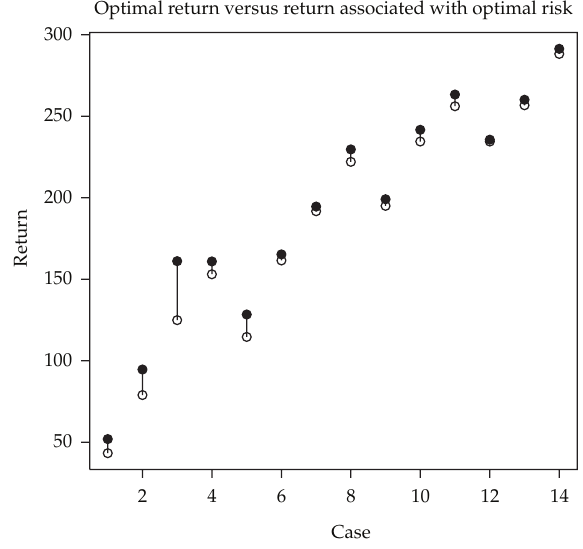
Figure 3: Optimal return Δ ∗ versus the return value Δ associated with the optimal risk for all